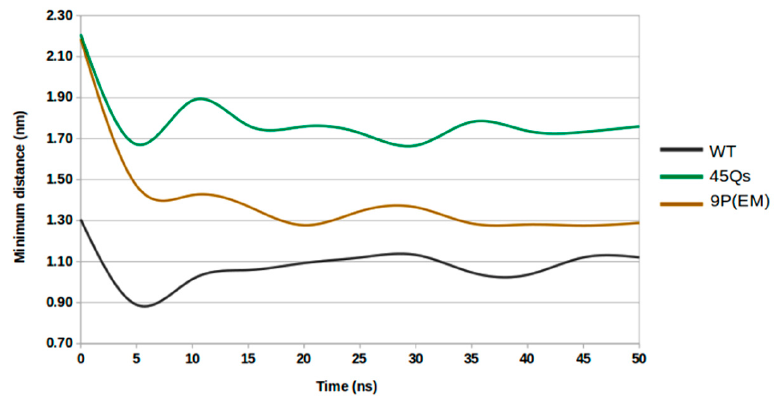
Figure 9. Plot of the minimum distances between the edges of the helix for the HTT models as a function of time.